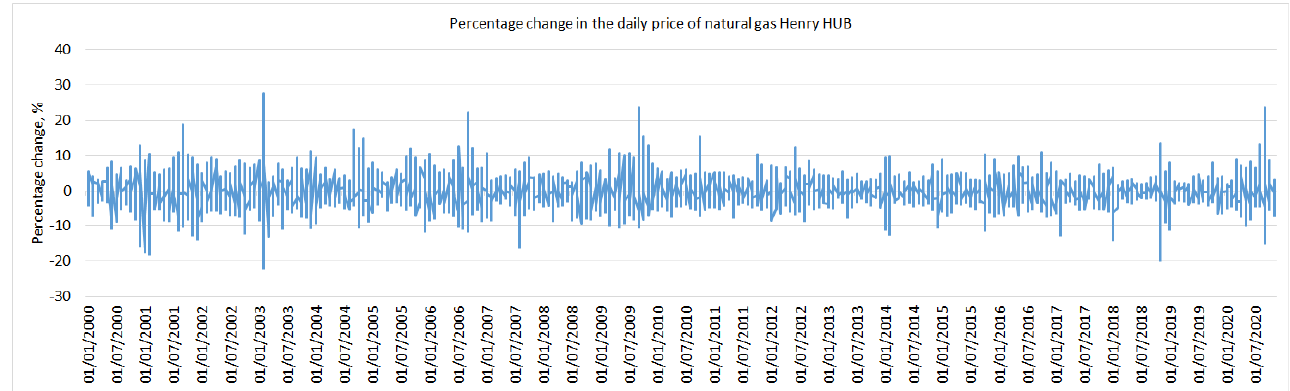
Figure 7. Percentage reference of the variation of the daily price of natural gas Henry HUB [40].